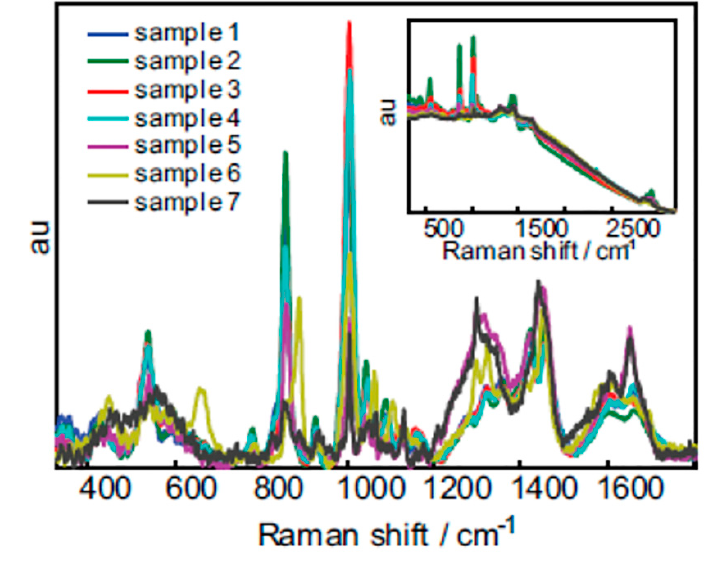
Figure 3. Average raw (insert) and after baseline correction spectra from seven sweat samples [93].